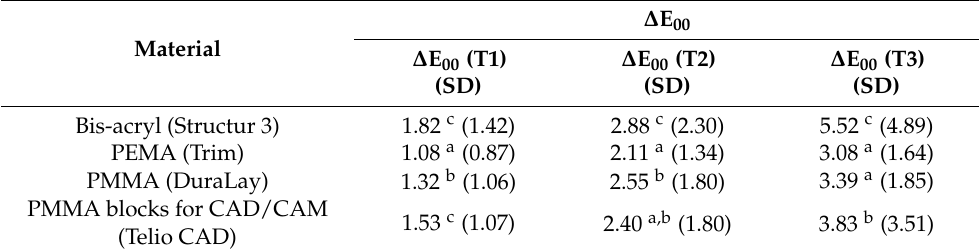
Table 3. Mean of the color changes ( ∆ E 00 ) for each material immersed in different staining solutions according to the time (Equation (1)).